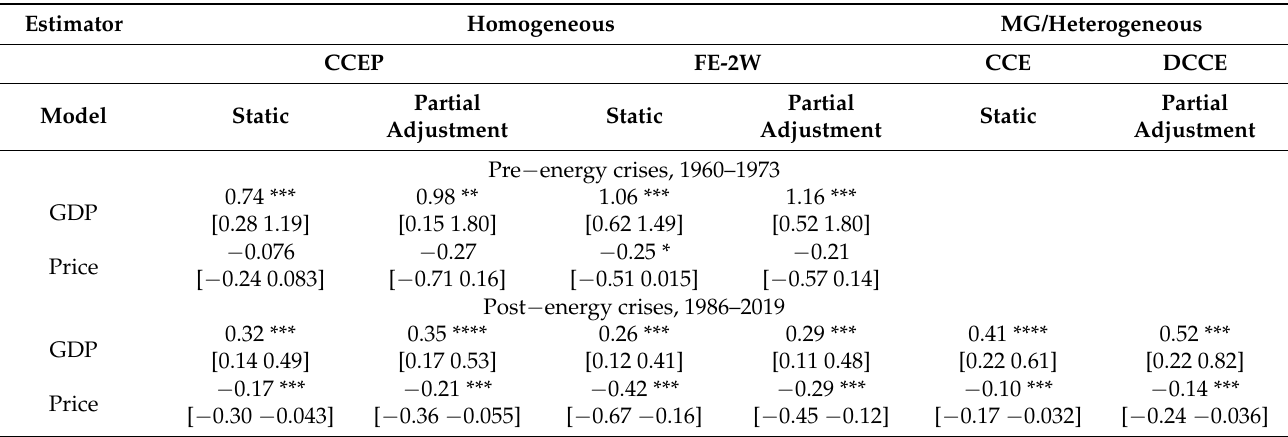
Table 2. Long-run elasticities 1960–1973 (pre-energy crises) and 1986–2019 (post-energy crises), 22 OECD countries (balanced